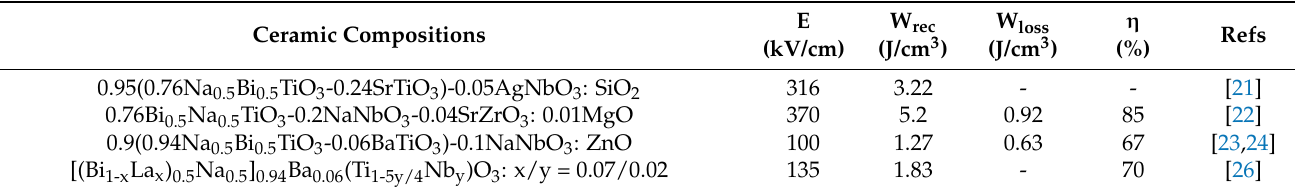
Table 2. ESP of BNT-based ceramics by oxides